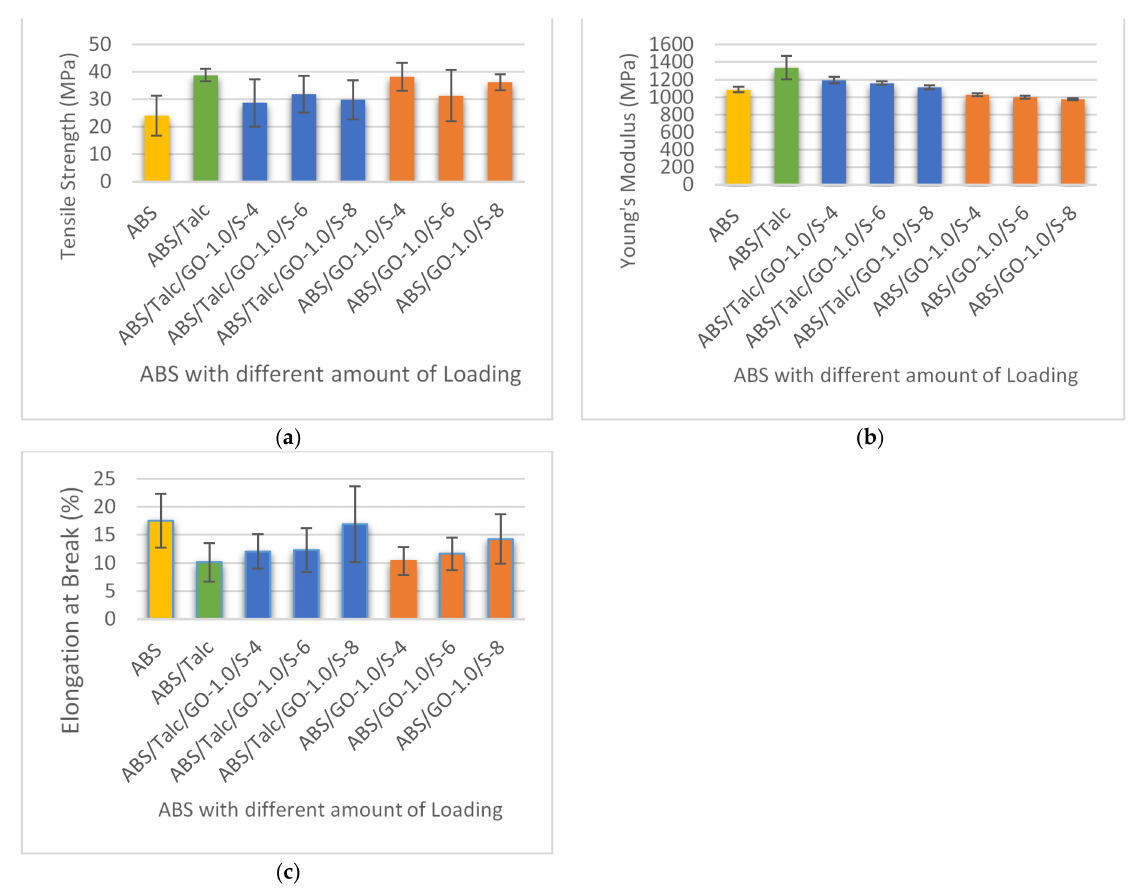
Figure 5. ( a ) Tensile strength, ( b ) Young’s modulus, and ( c ) elongation at break of ABS and ABS/talc, with different loading of